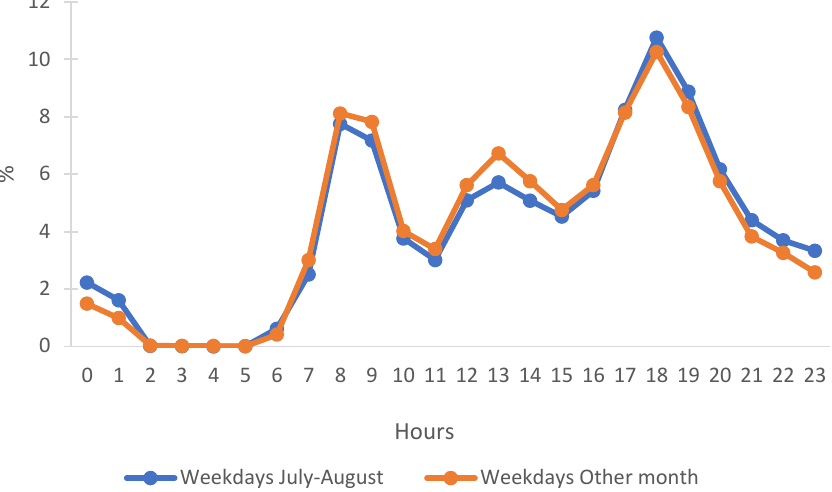
Figure 10. Percentage of overall trips in July–August versus other months in 2018.